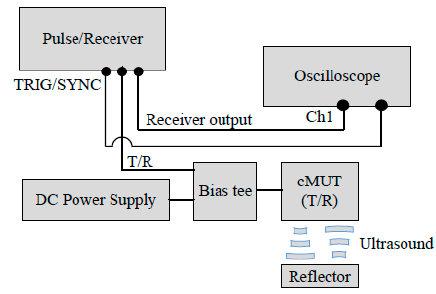
Figure 16. CMUT pulse-echo test framework.